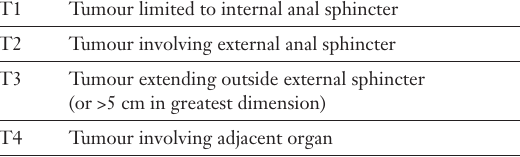
Ultrasound staging of anal